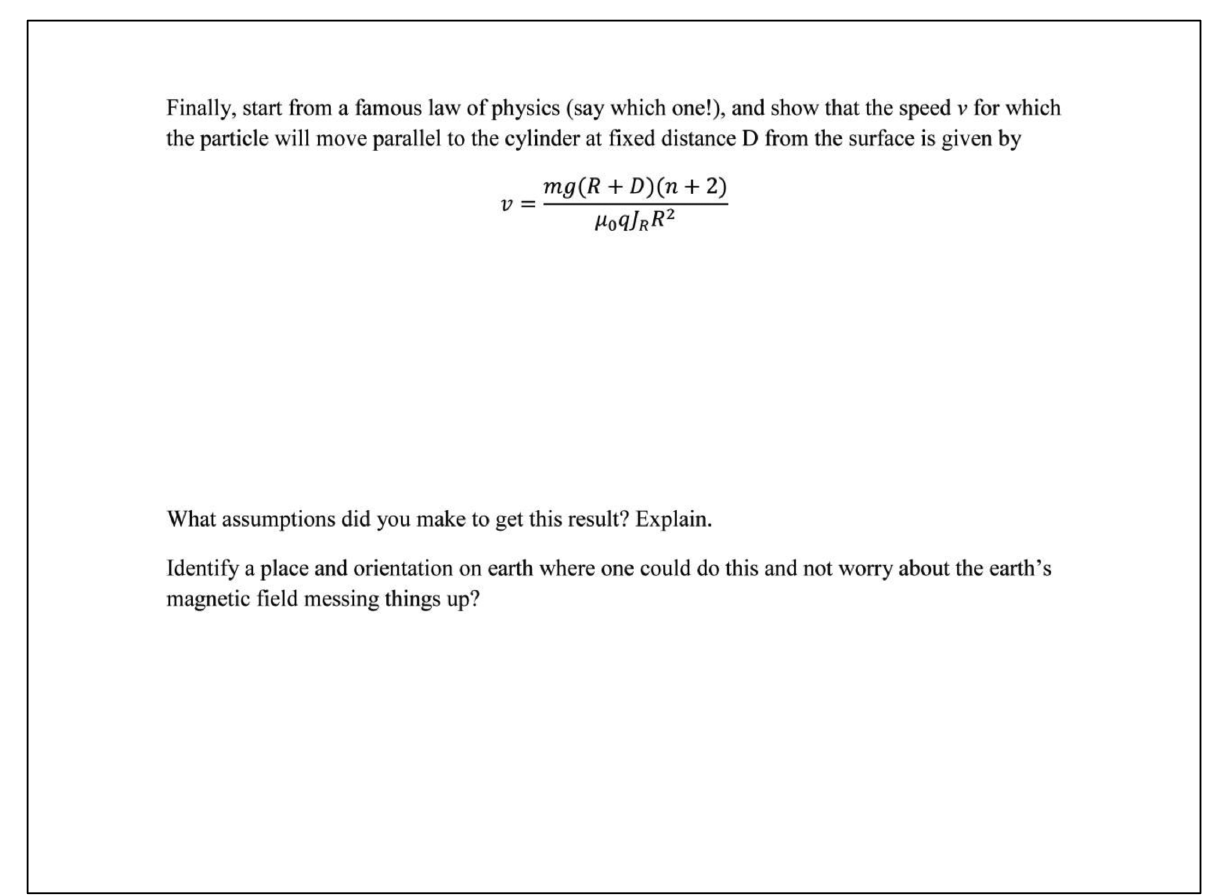
FIG. 20. Magnetic field around a conducting cylinder problem referenced in Fig. 11, layer 1, part